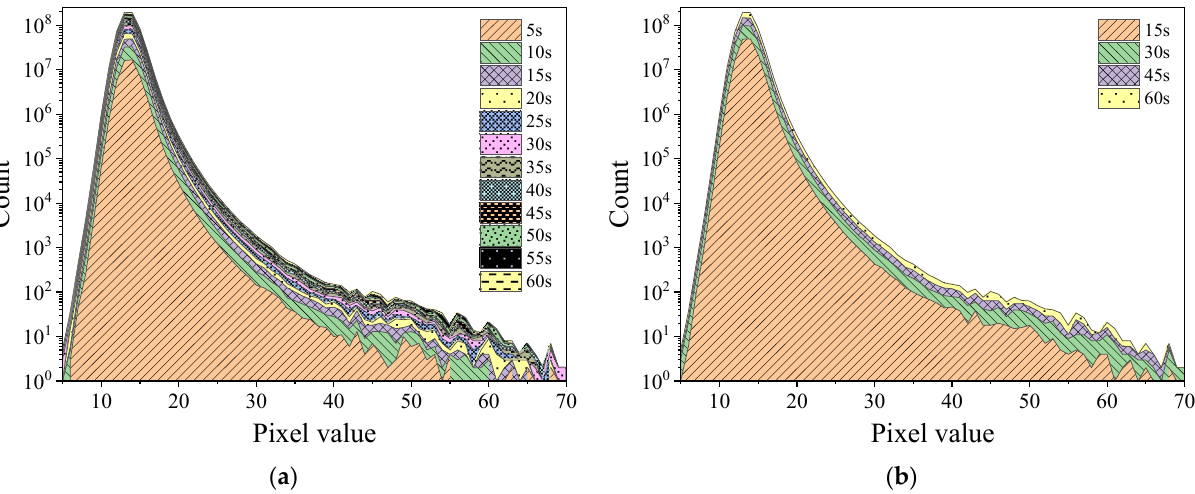
Figure 5. Histogram of the accumulation of 252 Cf source radiation signal over time (24 frames per second). ( a ) Stacking once every 5 s. ( b ) Stacking once every 15 s.